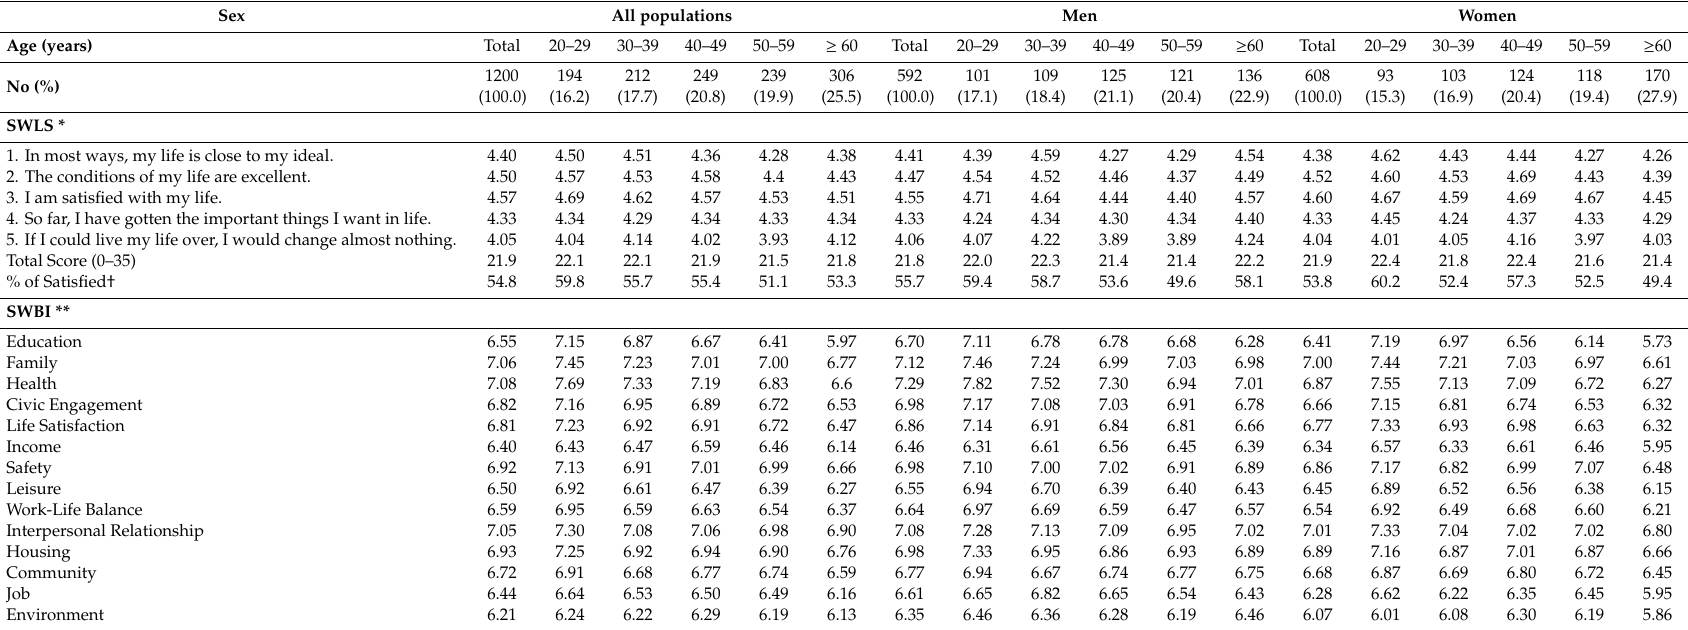
Table 4. Crude Mean Scores of Subjective Well-Being and Satisfaction with Life by Sex and Age